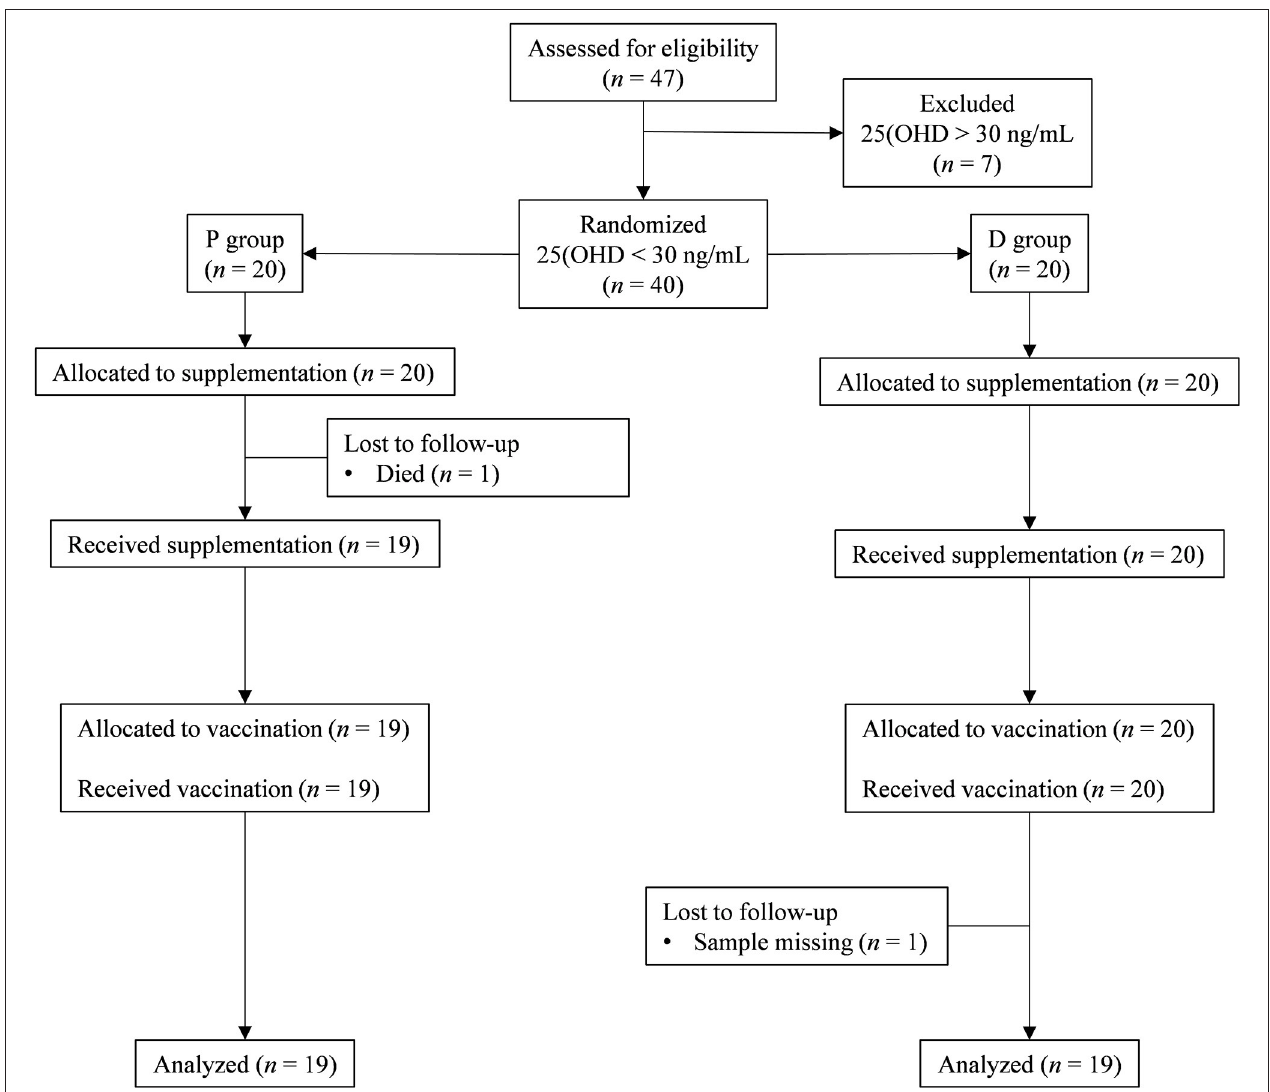
FIGURE 1 | CONSORT flow chart. The flow of participants through the trial is represented by a diagram, as suggested by the CONSORT group. P group, Placebo supplementation; D group, Vit-D